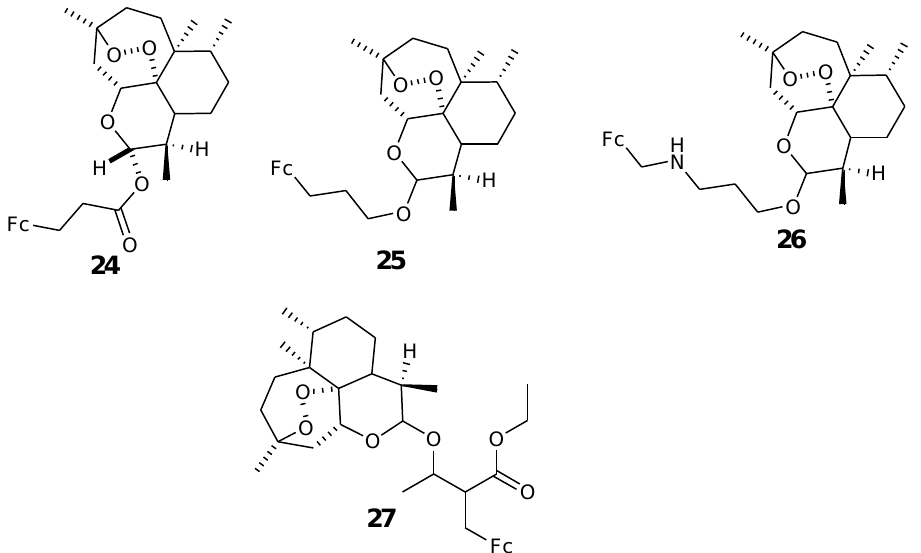
Figure 10. Chemical structures of dihydroartemisinin ferrocene derivatives ( 24 – 27 ).